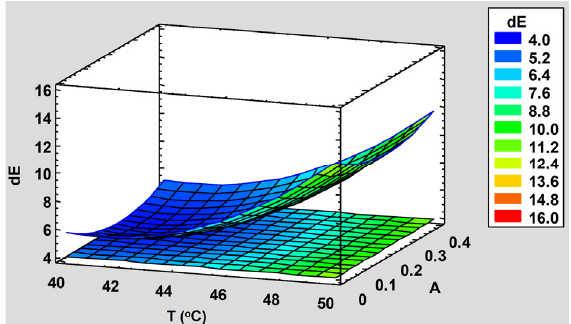
Figure 23. Effect of T and A on color change dE.